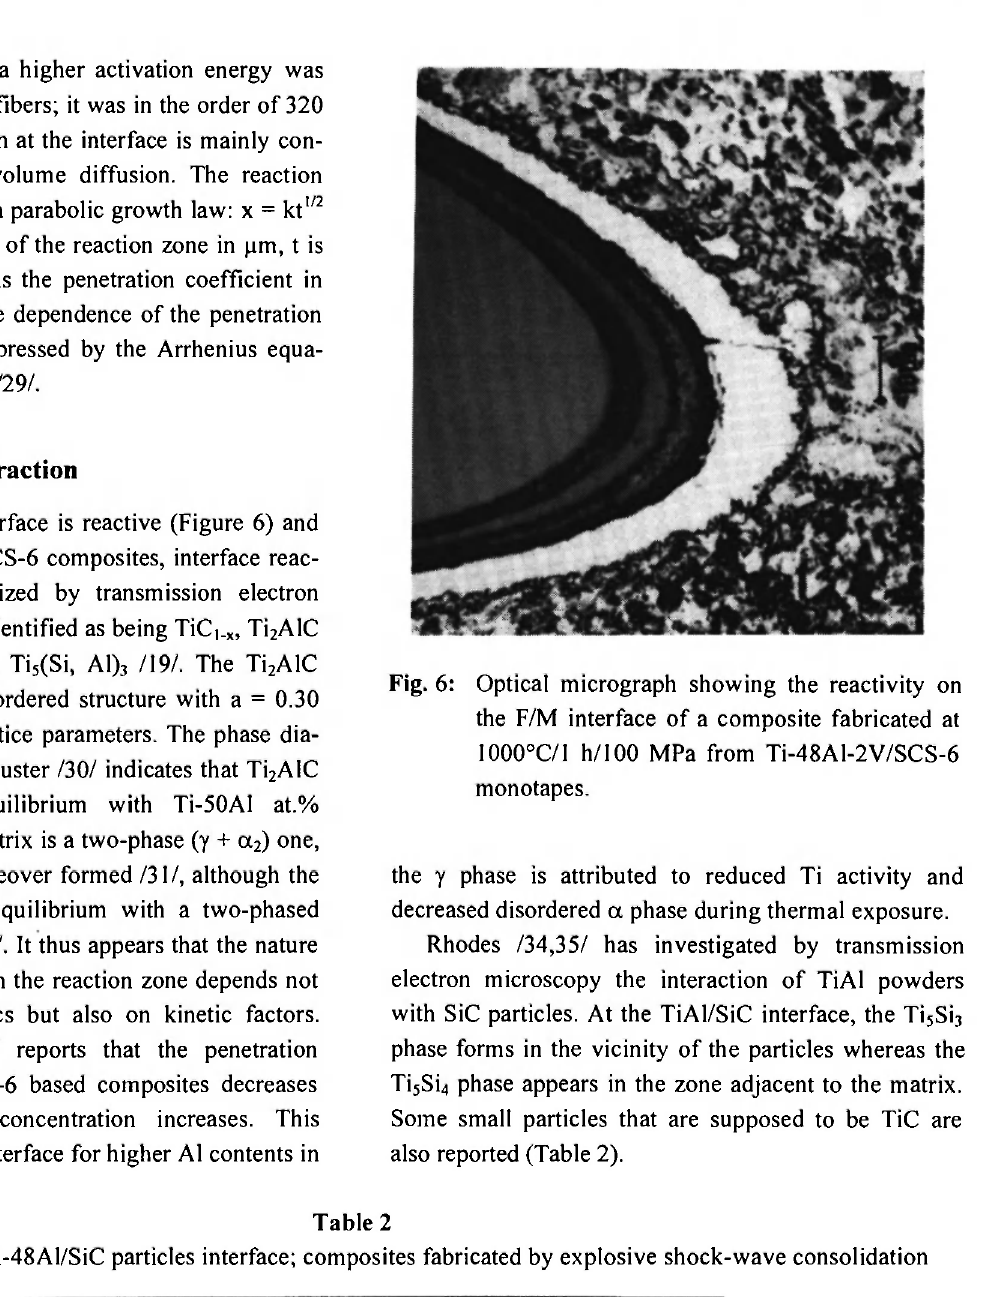
Phases observed at Ti-48Al/SiC particles interface; composites fabricated by explosive shock-wave consolidation Nature of